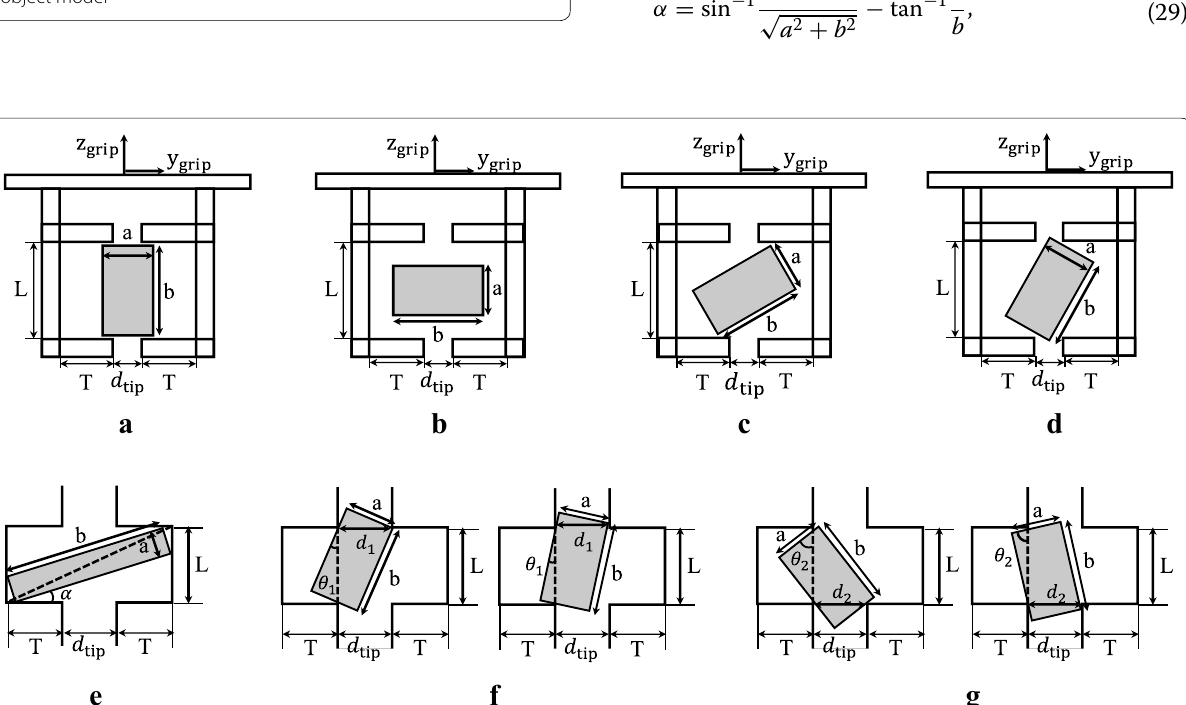
Fig. 16 Rigid-part caging condition. a Longitudinal, b lateral, c diagonal (i), and d diagonal (ii) directions. Also, e Critical state of c , and f , g critical states of